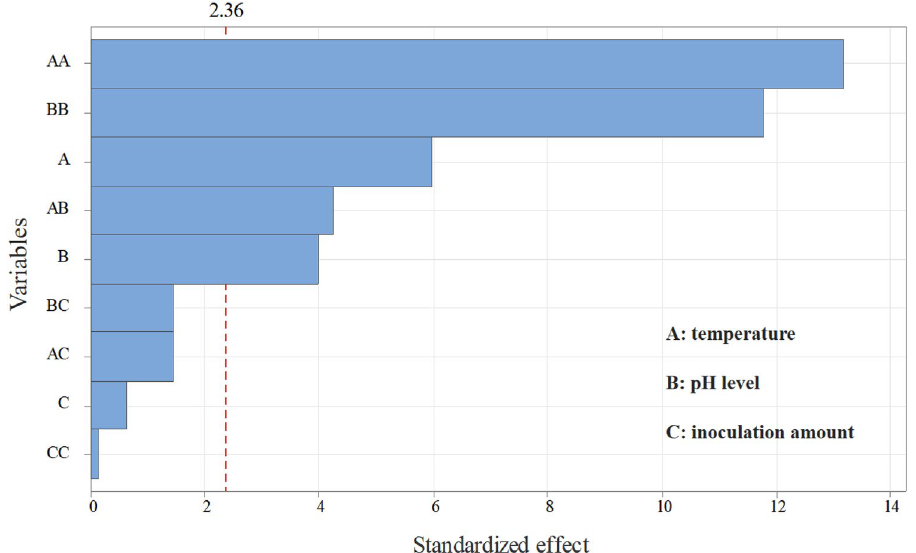
Figure 4. Pareto chart showing the effect of single factor (variables) biodegradation efficiency.